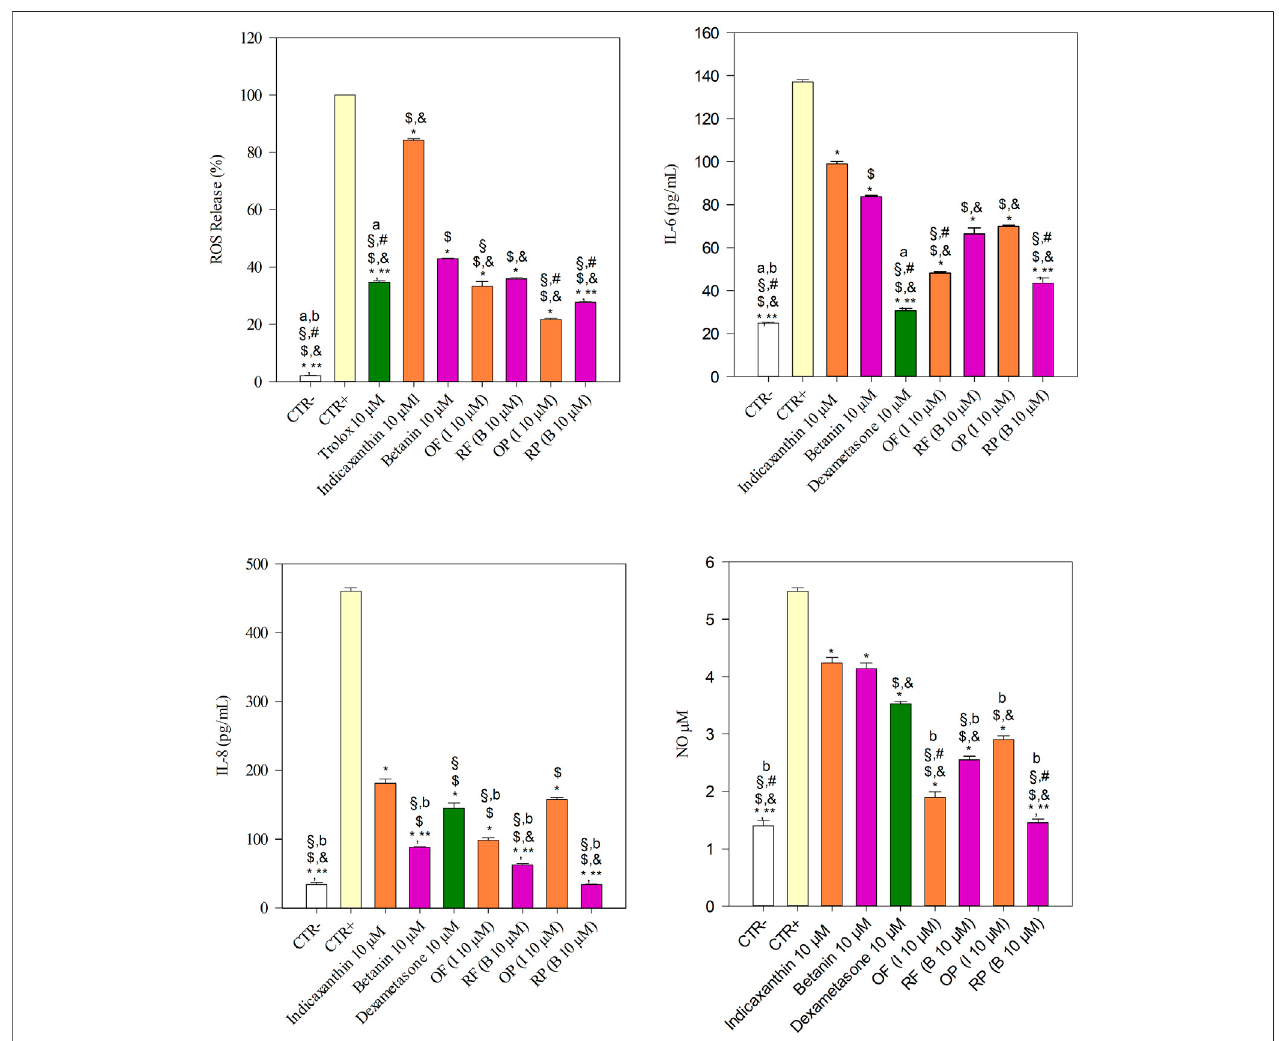
FIGURE 2 | Evaluation of the antioxidant and anti-in fl ammatory activities of equimolar concentration (10 µM) of indicaxanthin, betanin, orange fl esh and peel (OF andOP,respectively),andred fl eshandpeel(RFandRP,respectively)incomparisonwiththereferenceantioxidantcompound(10 µMtrolox)andanti-in fl ammatorydrug (10 µM dexamethasone) by a cell-based assay carried out on a Caco-2 transwell model. IL-1 β (25 ng/ml) was used to trigger the in fl ammation (CTR+), whereas DMEM with0.1%DMSO wasusedasthenegativecontrol(CTR-). Results were expressed asROSreleasepercentage(%)and asconcentration (pg/mLforIL-6 andIL-8, and µM for NO) of in fl ammatory markers released after cell treatments ± S.D. of ten independent experiments in triplicate ( n (cid:2) 3); * p < 0.001 vs. CTR+, $ p < 0.001 vs. indicaxanthin, & p < 0.001 vs. betanin; § p < 0.001 vs. OP; # p < 0.001 vs. RF, ** p < 0.001 vs. OF; a p < 0.001 vs. RP, b p < 0.001 vs. trolox or